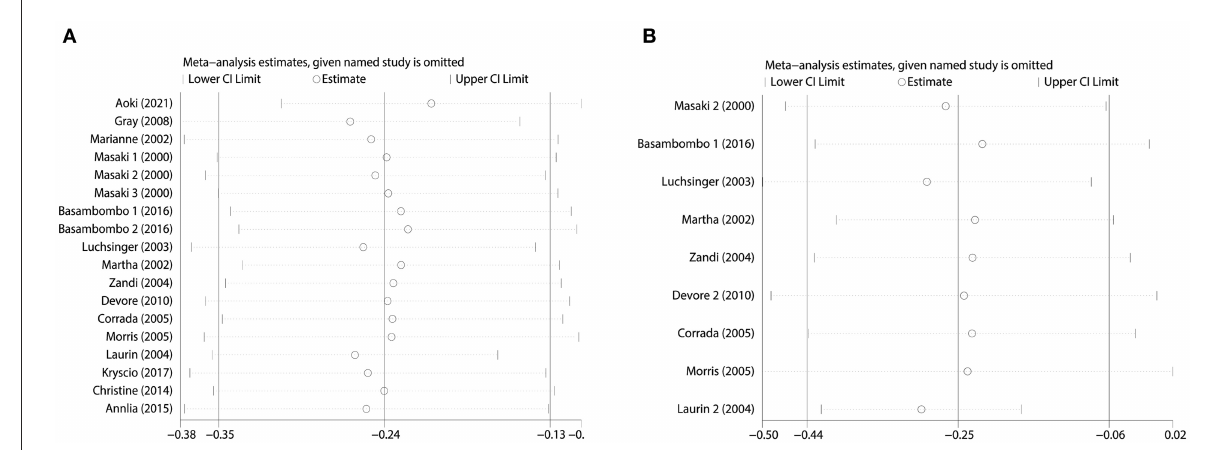
FIGURE5 Sensitivity analysis. (A) Sensitivity analysis of combined dietary and supplement use and risk of dementia. (B) Sensitivity analysis of combined dietary and supplement use and risk of